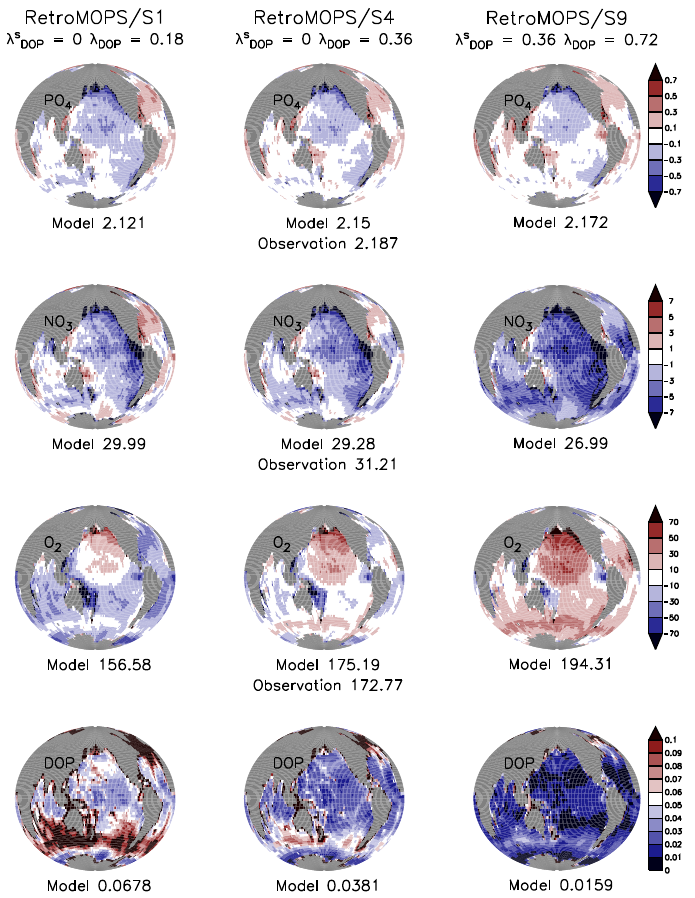
Figure 5. As in Fig. 3, but for three sensitivity experiments with model RetroMOPS.